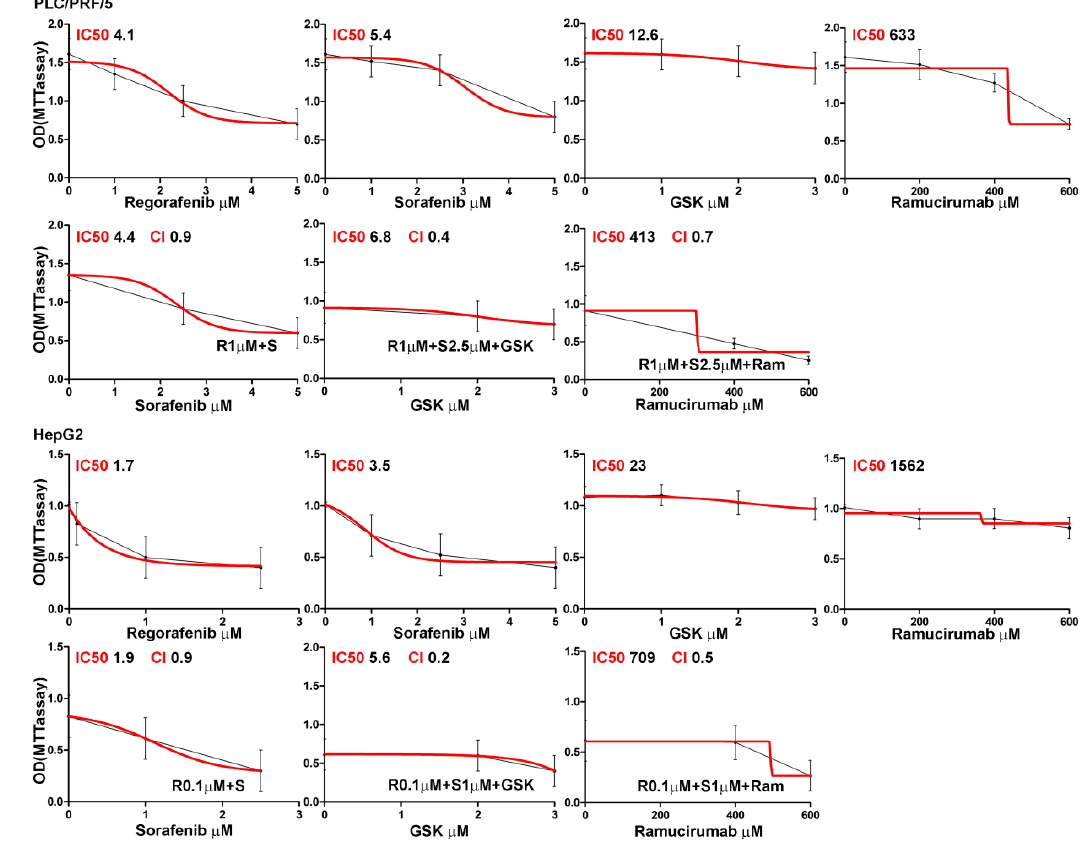
Figure 1. Dose response curves relative to each single or combined treatment in PLC/PRF/5, and HepG2 cells. PLC/PRF/5 and HepG2 cells were cultured in medium containing different concentrations of regorafenib (1, 2.5, 5 μ M for PLC/PRF/5 and 0.1, 0.5, 1 μ M for HepG2), sorafenib (1, 2.5, 5 μ M), GSK1838705A (1, 2, 3 μ M) and ramucirumab (200, 400, 600 μ M) used alone and in combination for 48 h. Dose-response curves were generated for each drug or drug combination and relative IC50 and the CIs were indicated on the respective graph. The results of three independent experiments are expressed as means ± SD.